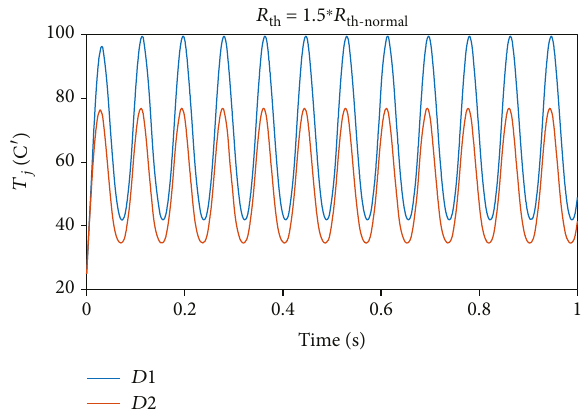
Figure 6: Junction temperature of parallel-connected power modules ( D 1 aged to 1 5 ∗ R th − normal ).